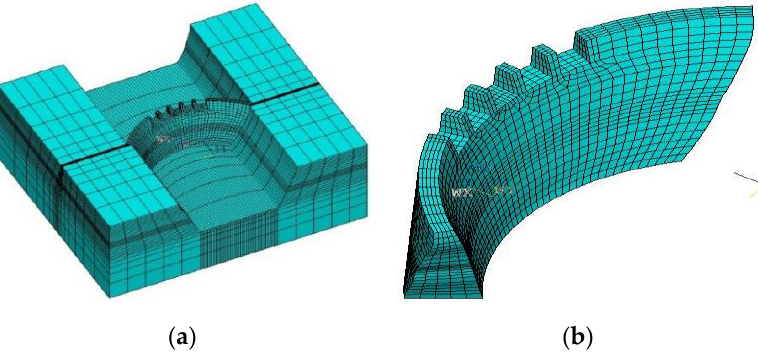
Figure 3. ( a ) Finite element model of the foundation rock system of the Jiancaogou single-curvature arch dam. ( b ) Finite element model of the dam body.